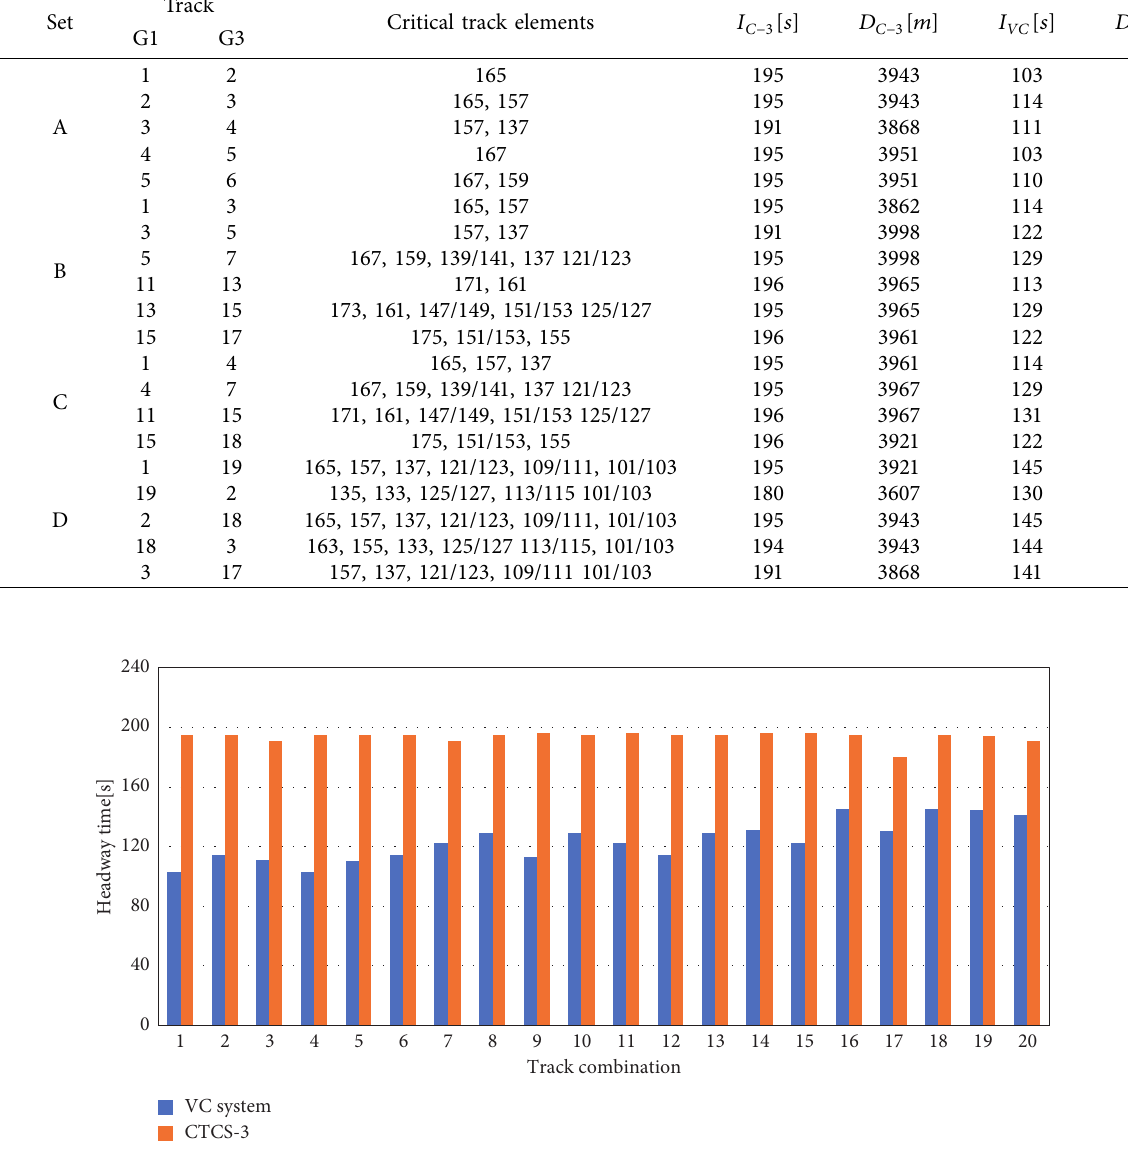
Figure 13: Outcomes of train headways for scenario